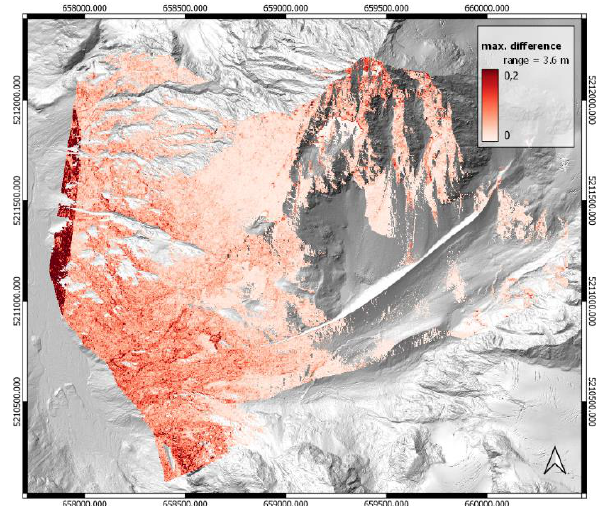
Figure 4. Maximum difference between neighbouring pixels in projected ExG image within the range of mean GCP projection error of 3.60